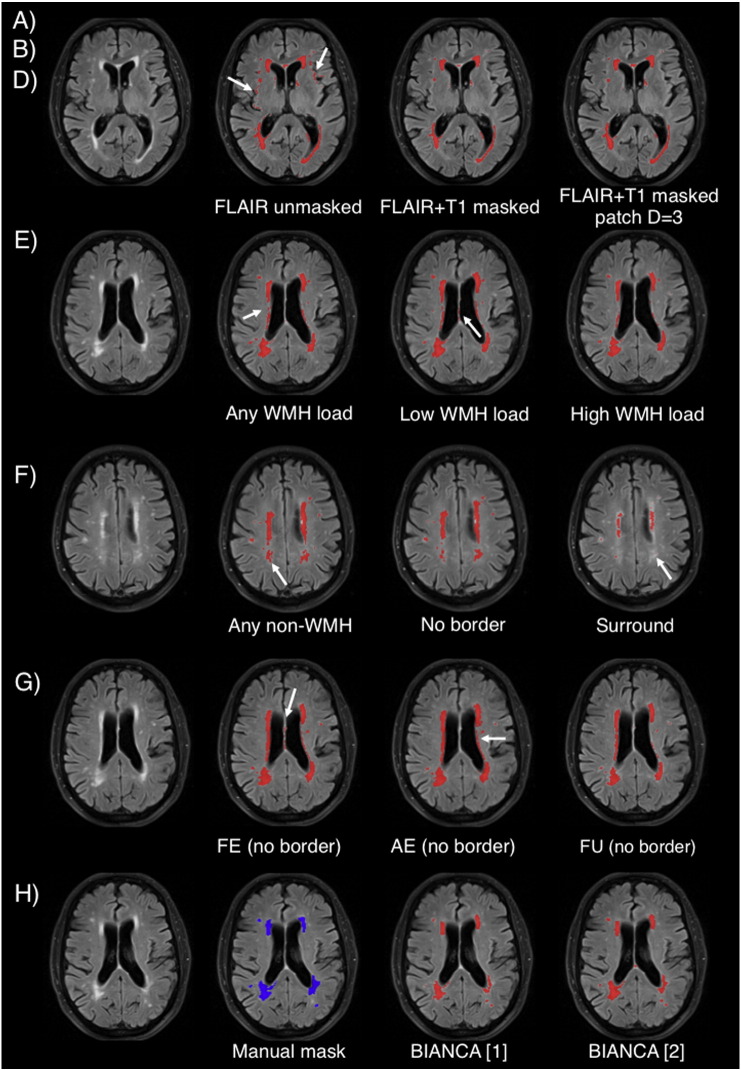
BIANCA optimisation. Examples of BIANCA output from some of the options tested (especially those not already evaluated in literature) on one subject from Dataset 1 (male, 76 years): A) and B) Multimodal MRI and masking; D) “patch” option; E) training subjects; F) localisation of training points; G) number of training points; H) combination of best options, shown next to the manual mask. The white arrows point at segmentation errors. Please refer to main text for details about the options.